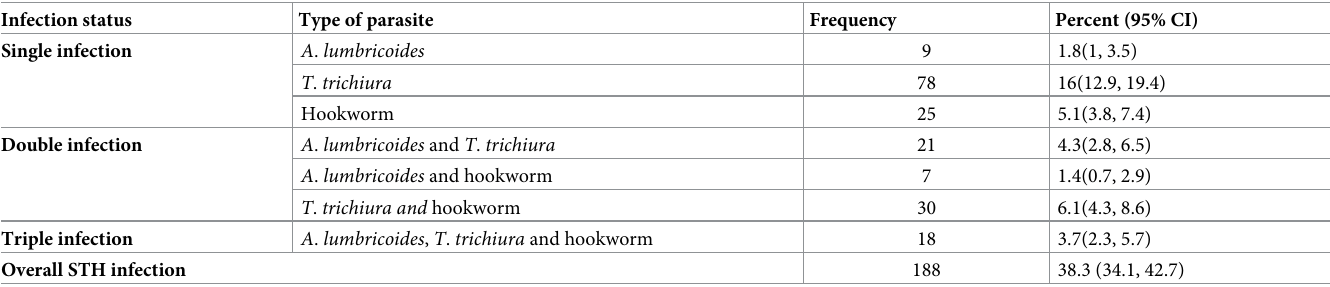
Table 2. STH infection in Yeki district of southwest Ethiopia (2017). Infection